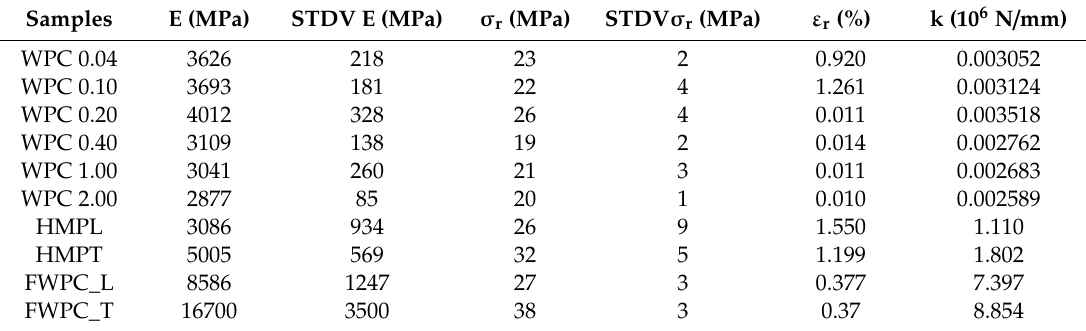
Table 4. Average values of elastic characteristics obtained after the tensile test. Legend: E—longitudinal elasticity modulus; STDV—standard deviation; σ r —tensile of rupture; ε r —percentage strain at break; k—sti ff